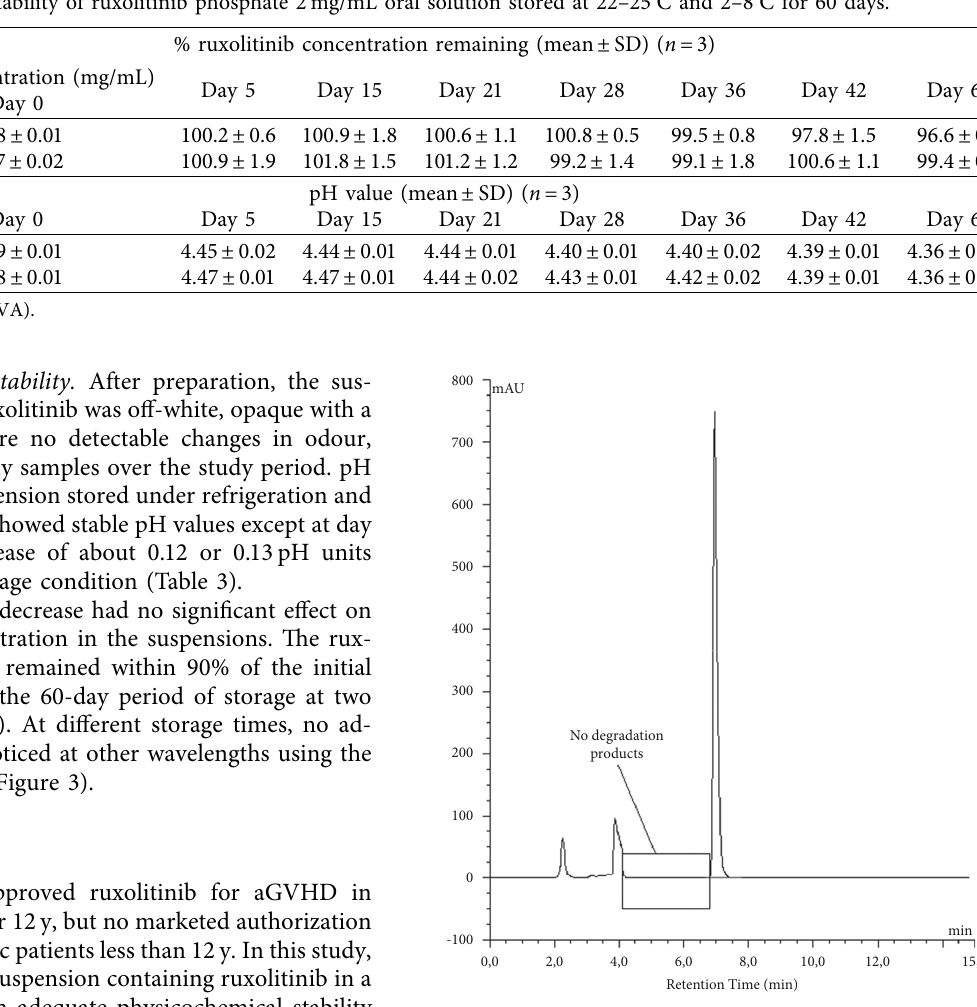
Figure 3: Chromatogram of ruxolitinib in Inorpha ® at 200 μ g/ml at day 60 and stored at room temperature.